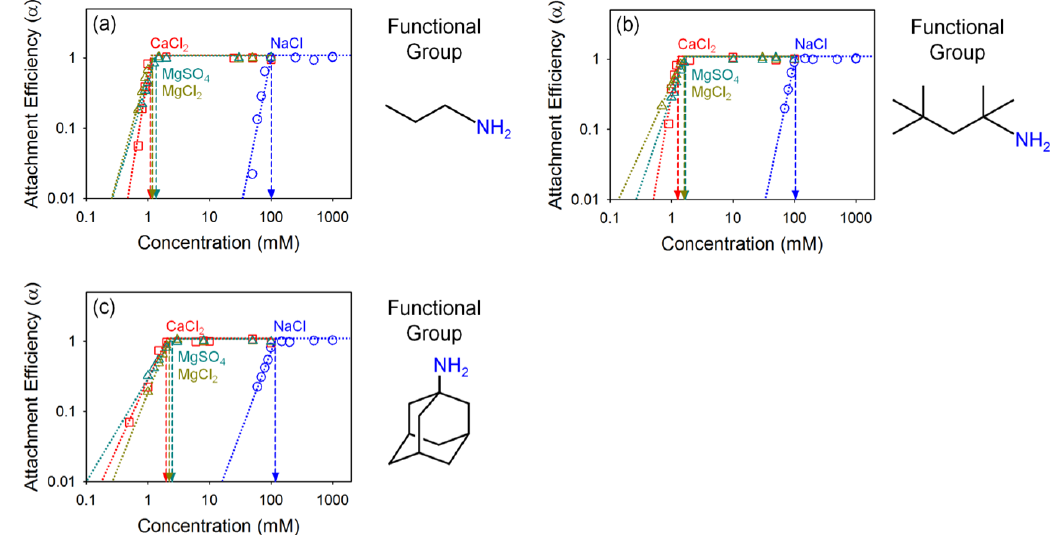
Figure 5. Attachment efficiency of ( a ) propylamine GO, ( b ) tert-octylamine GO, and ( c ) 1-adamantylamine GO as a function of salt concentration; NaCl (blue), CaCl 2 (red), MgCl 2 (dark yellow), and MgSO 4 (dark green).